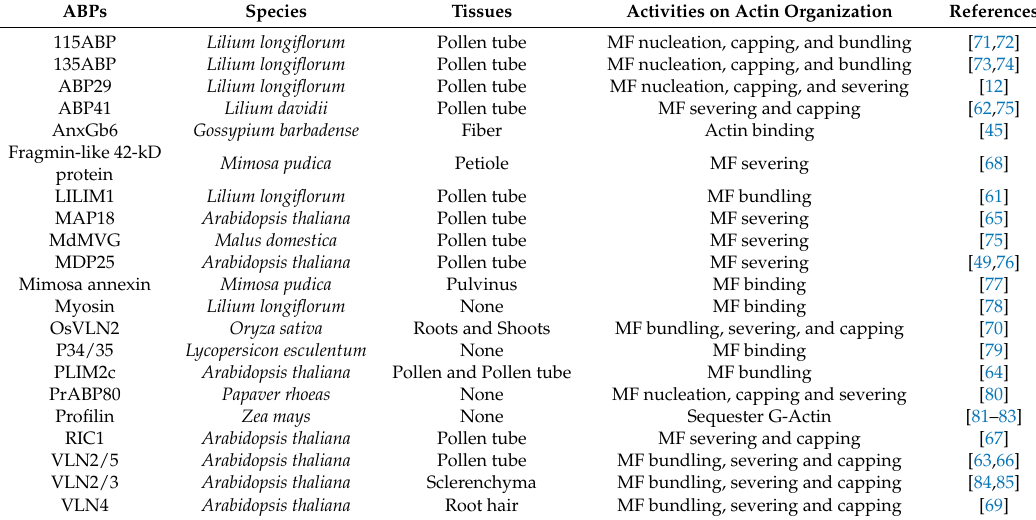
Table 1. Summary of calcium-dependent actin-binding proteins.